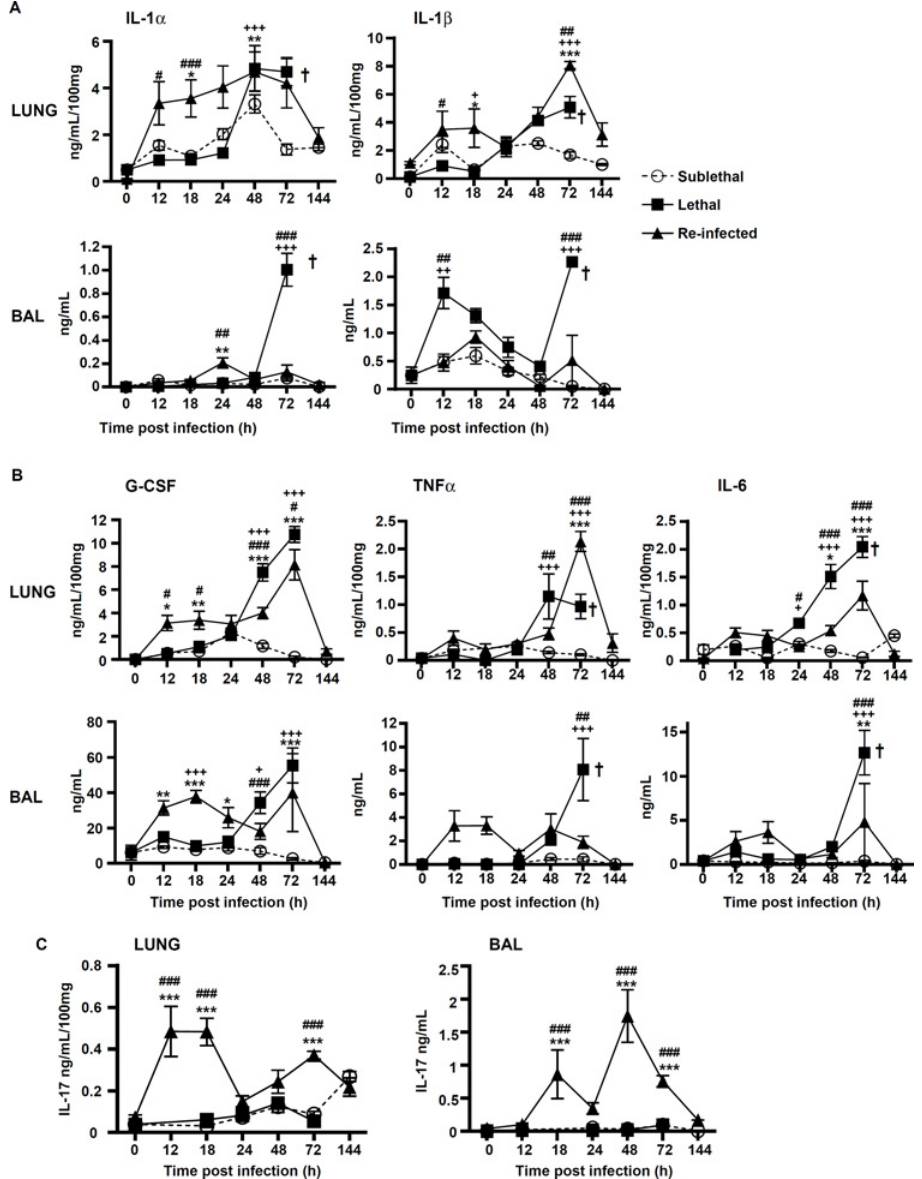
Fig 5. Protection correlates with early production of pro-inflammatory mediators. Mice were either infected at day 0 with a sublethal (SL) or a lethal (L) concentration of A . fumigatus conidia. Re-infected (Re- Inf) mice were first infected with a SL dose and 10 days later were challenged with the L dose. Mice were sacrificed at 0, 12, 18, 24, 48, 72, and 144 h p.i. The time point 0 h p.i. of the Re-Inf mice corresponds to the day 10 of the SL mice (see S1 Fig). The BAL and lungs tissue homogenates were were assessed by ELISA for quantification of (A) IL-1 α , andIL-1 ββ , (B) G-CSF, TNF α and IL-6, and (C) IL-17. Data (mean ± SEM) represent 2 to 3 independent experiments with n = 5 mice per experiment. Statistically significant differences were determined using a Two way ANOVA with Bonferroni post-test (+p < 0.05, ++p < 0.01, +++p < 0.001 SL vs LL dose; * p < 0.05, ** p < 0.01, *** p < 0.001 Re-Inf vs SL dose; #p < 0.05, ##p < 0.01, ###p < 0.001 LL dose vs Re-Inf